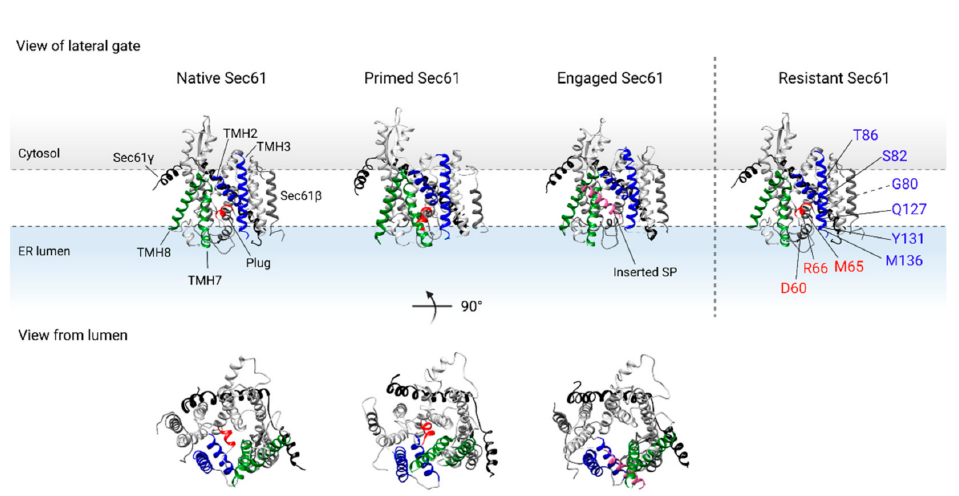
Figure 3. Dynamics of the TMHs of the Sec61 translocon (PDB 5A6U [69]) upon binding of the ribosome (primed state, PDB 3J7Q [52]) and insertion of the SP (engaged state, PDB 3JC2 [27]). Sec61 α is shown in grey, Sec61 β is shown in dark grey, and Sec61 γ is shown in black. The interhelical interaction between TMH2 and TMH3 (shown in blue) on one half of the translocon, and TMH7 and TMH8 (shown in green) on the other half of the translocon form the lateral gate of Sec61 α . Additionally, the translocon is closed axially by the lumenal plug domain of TMH2 (shown in red). Binding of the ribosome disrupts the interaction of TMH3 and TMH8 of the lateral gate and primes the translocon for insertion of the nascent protein chain, while the plug domain remains in place. The SP of the nascent chain (shown in pink) interacts with the lateral gate of the translocon, resulting in lateral escape from the translocon and insertion of the TMD into the ER membrane. In addition, the plug domain is displaced to allow for protein translocation into the ER lumen. Resistance conferring mutations located in the lateral gate or plug domain of Sec61 α are shown in ‘Resistant Sec61’.